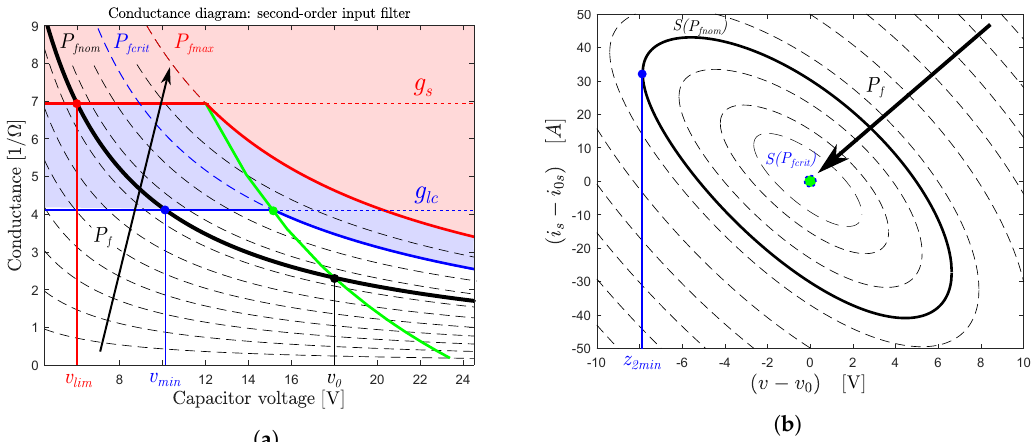
Figure 8. llustrative diagrams ( a ) of conductance and ( b ) of invariant region for second-order filter with variable power P f and fixed f c and C f